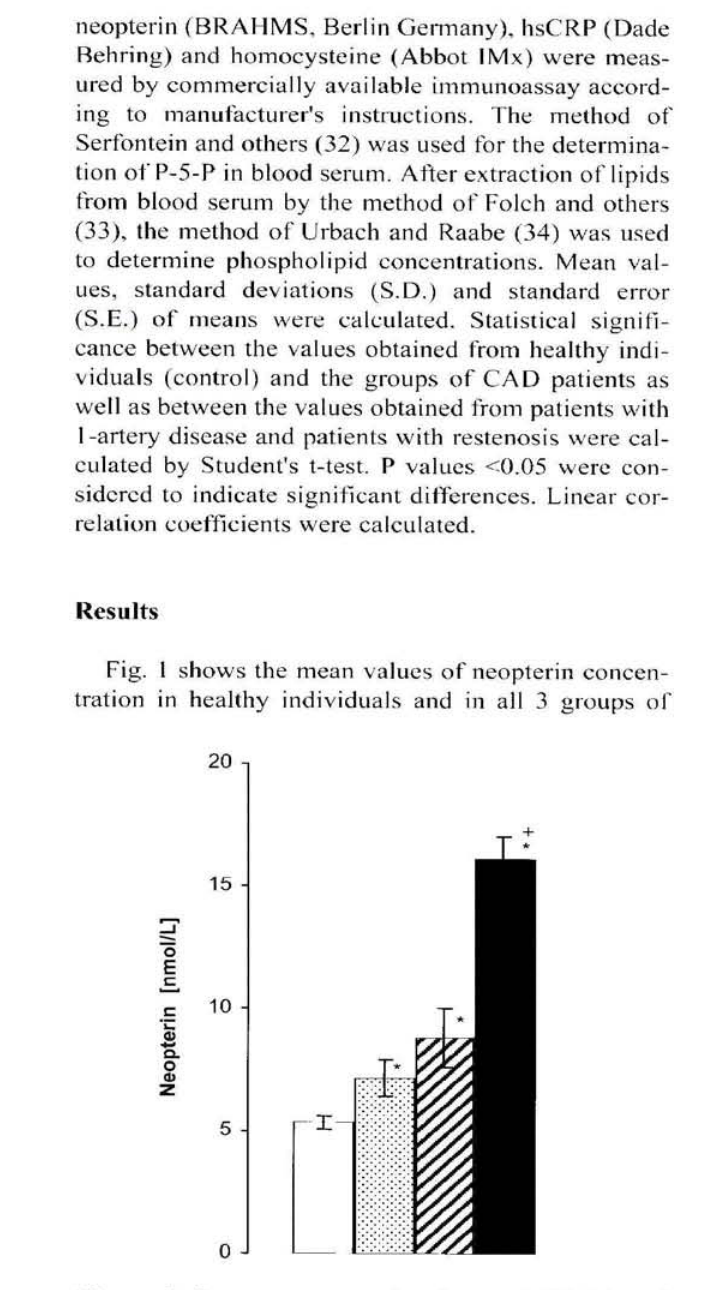
Figure 1. Serum concentration (mean ± S.F..M.) of neopterin in healthy individuals (open bars) and in CAD patients before percutaneous transluminal coro- nary angioplasty due to 1-artery disease (dotted bars), 2- or 3-artery disease (hatched bars), and restenosis (black bars). *The changes are significant if compared with healthy individuals (P <0.001) or with patients with 1-artery disease. CAD patients. Concentrations of neopterin in healthy individuals oscillated from 2.6 to 8.7 nmol/L: the mean